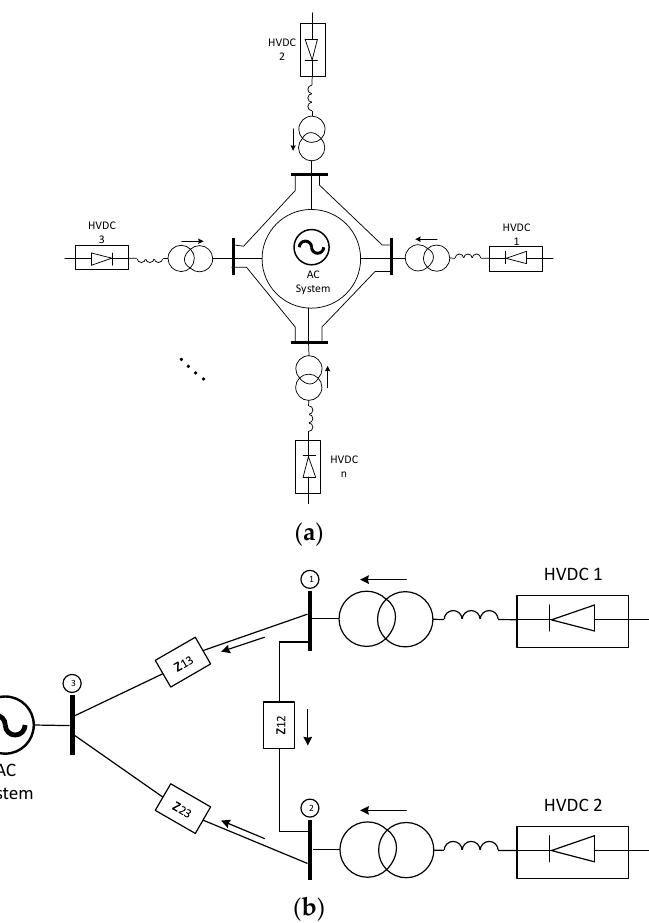
Figure 1. ( a ) Ring-type multi-infeed Dc system; ( b ) dual infeed ring-type multi-infeed Dc system.